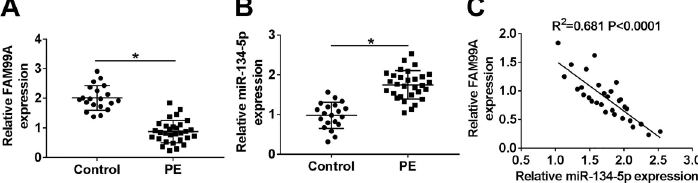
Figure 1. FAM99A was down-regulated, but miR-134-5p was signi fi cantly up-regulated in preeclampsia (PE) tissues. A and B , The levels of FAM99A ( A ) and miR-134-5p ( B ) in PE tissues and normal pregnant placenta tissues were measured by qRT-PCR. C , A correlation between FAM99A and miR-134-5p was detected. *P o 0.05 (Student ’ s t